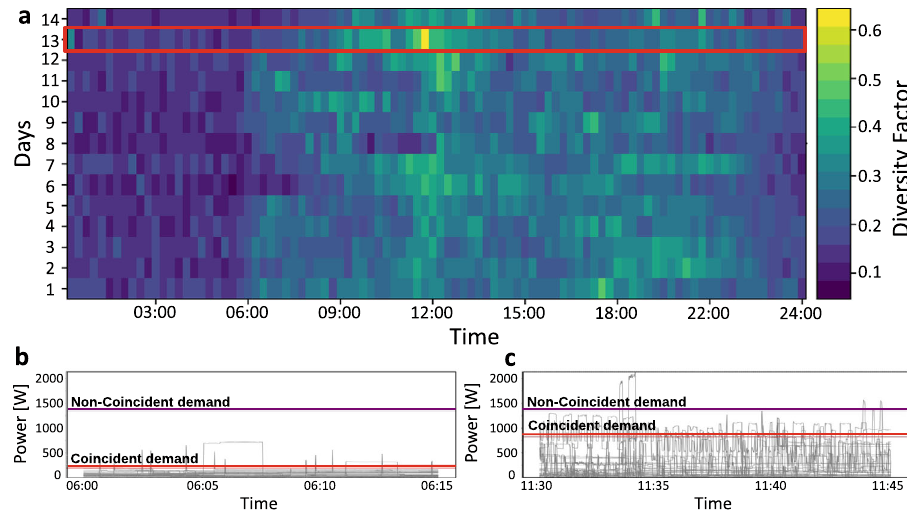
Fig. 2 Indicating the interaction between households' energy consumption by considering the diversity factor. a shows the diversity factor or the ratio between coincident demand, P cd , and non-coincident demand, P ncd , of 30 households belonging to the ADRES dataset every 15 min and for 14 days. As it is clear, there are some time intervals during a day whose diversity factor reaches 0.6. b , c respectively show the energy consumption trajectory of all 30 households from 6:00 to 6:15 and 11:30 to 11:45. It is clear from the fi gures that the energy consumption of all houses is low around 6:00 and then is gradually increasing together around 11:00 and, consequently the difference between P cd and P ncd is decreasing proving the obvious interaction between houses consuming the